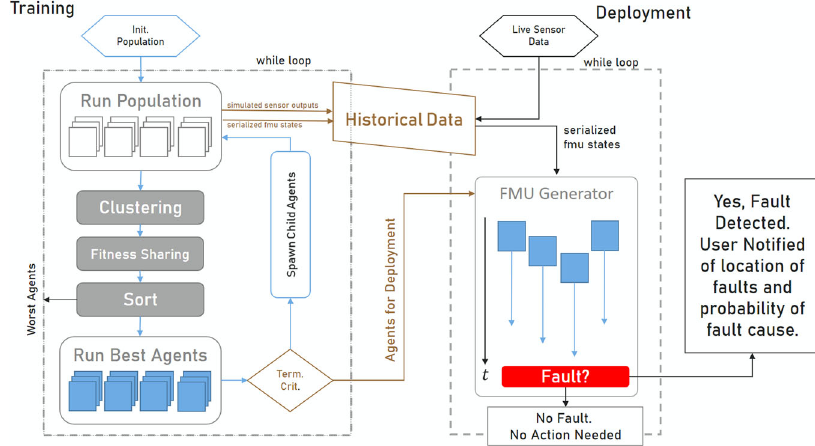
Fig. 3 Multiple ReLAAs are trained before they are deployed to detect